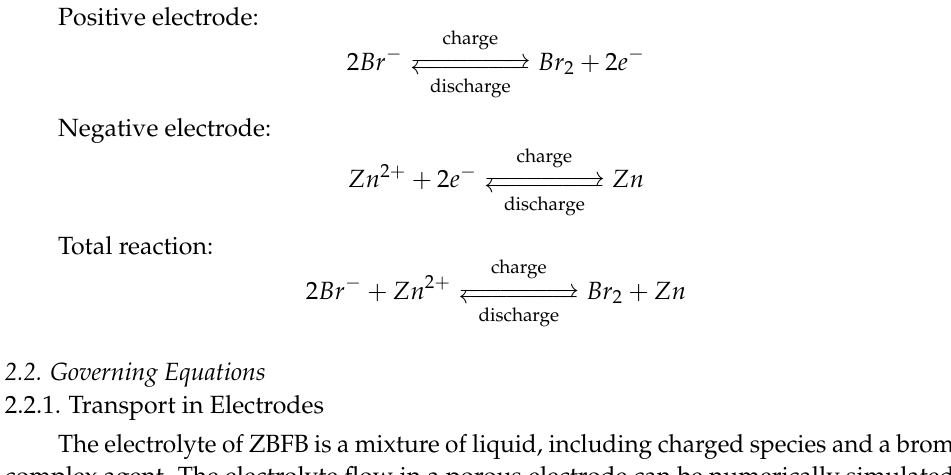
Figure 1. Schematic diagram of the structure and principle of ZBFB (BCA = bromine complex agent; OPC = oily polybromide complex).